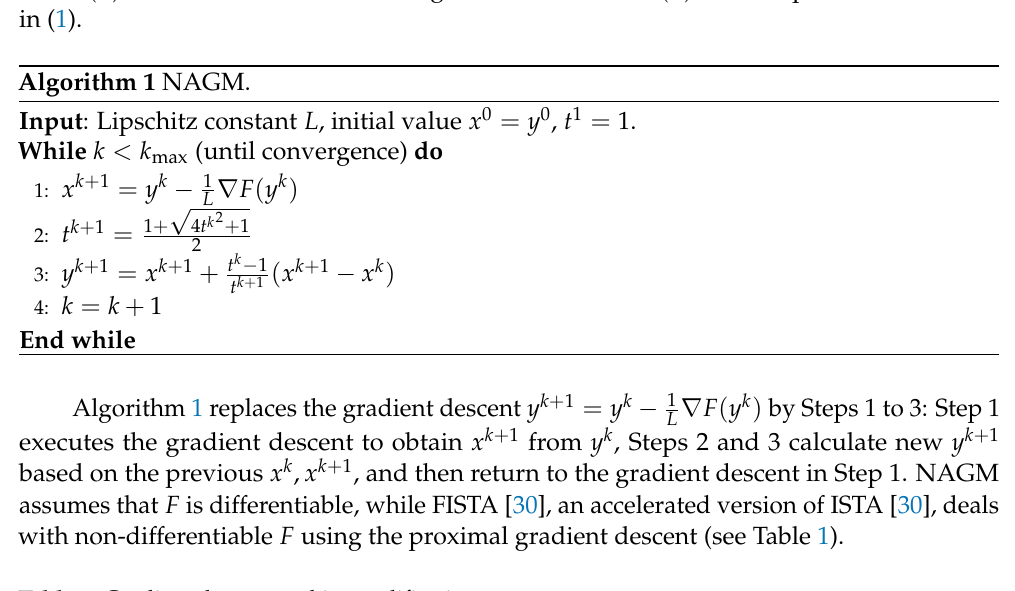
Table 1. Gradient descent and its modifications